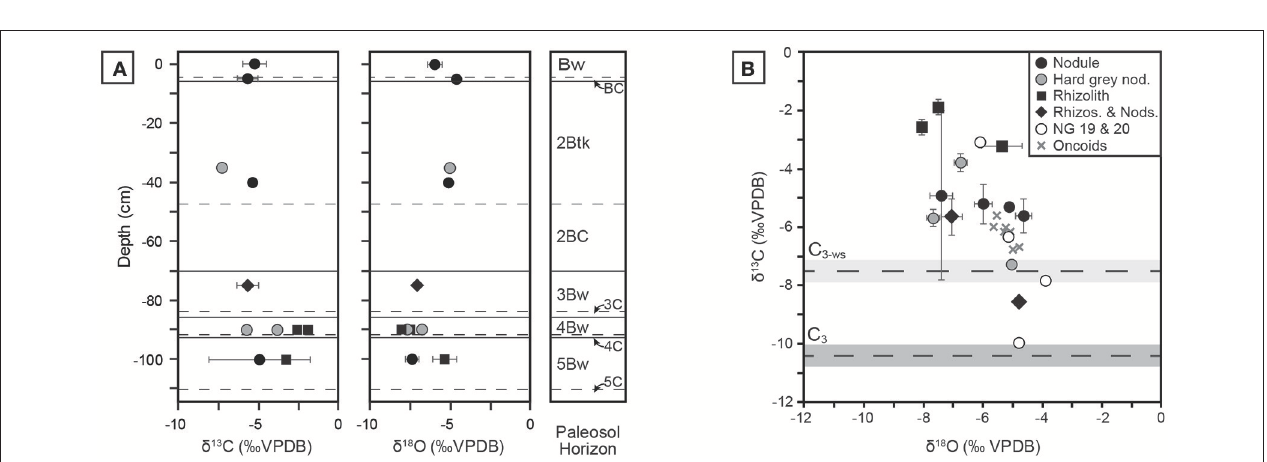
FIGURE 10 | Stable isotopic compositions of pedogenic carbonates from Ngira. (A) Profiles in NG15-B of pedogenic carbonates, coded by morphology and phase (see B for key). Each sample is the mean of triplicate analysis; 1 σ error bars about the mean are shown when error is greater than symbol size. (B) Cross-plot of δ 13 C vs. δ 18 O values, with calculated endmember compositions for C 3 and water-stressed C 3 (C 3 -ws) vegetation. The C 4 endmember is + 4.5 ‰ . Data for units NG19 and NG20, as well as lacustrine oncoid carbonates, are also plotted (from Driese et al., 2016).